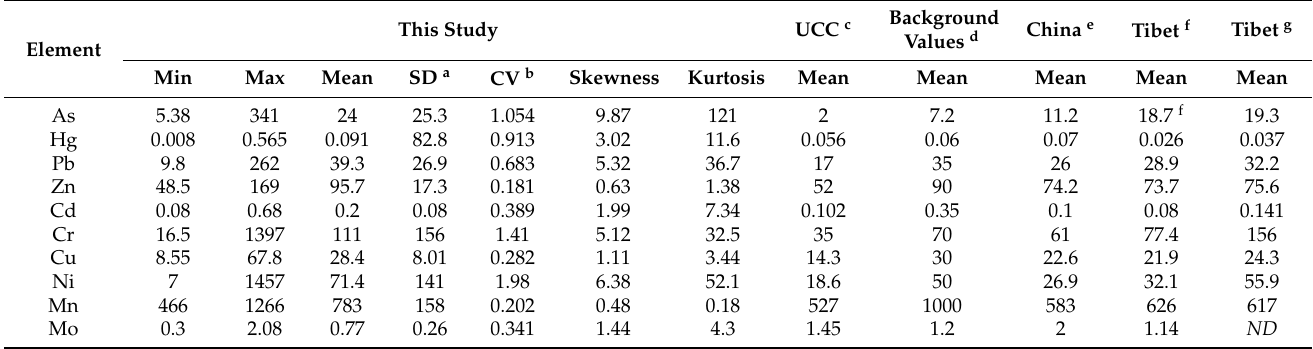
Table 3. Descriptive statistics of the heavy metals in the soil of eastern Tibet